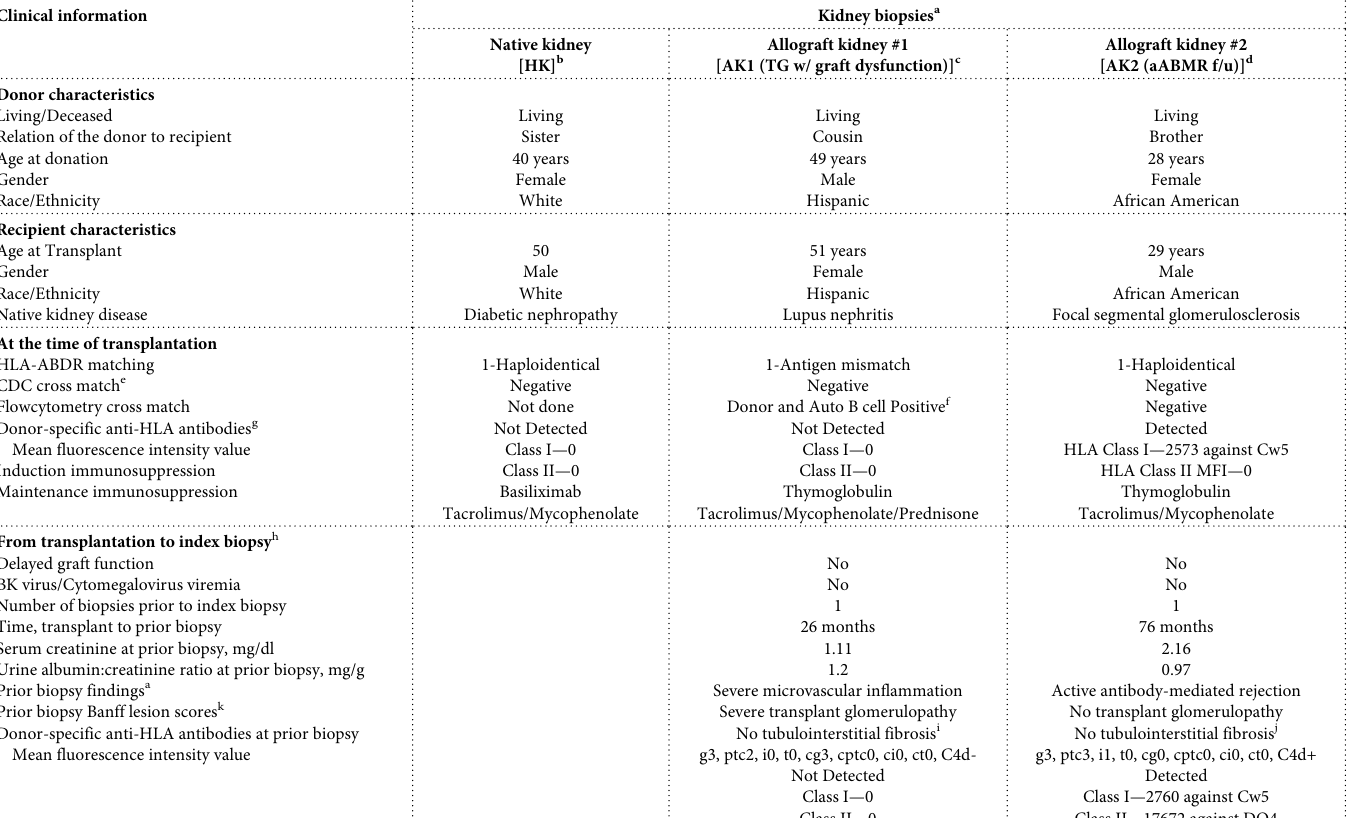
Table 1. Clinical characteristics of the three subjects whose kidney biopsies were used for scRNA-seq. Clinical